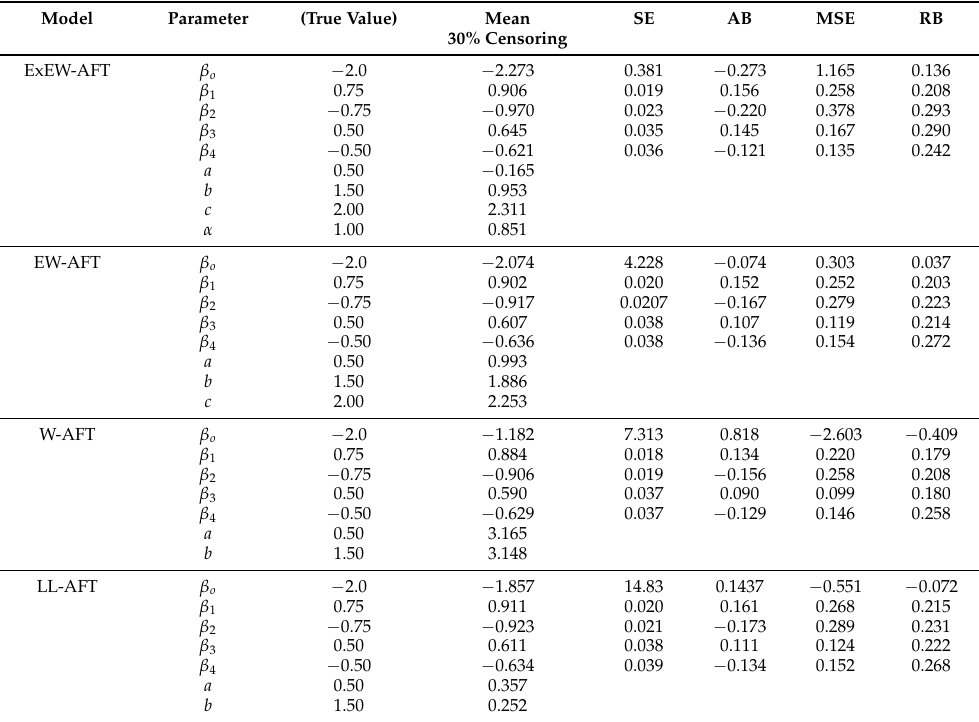
Table 11. Simulation study for scenario 3 ( n = 1000) with about 30% censored observations is used to compare model performance.